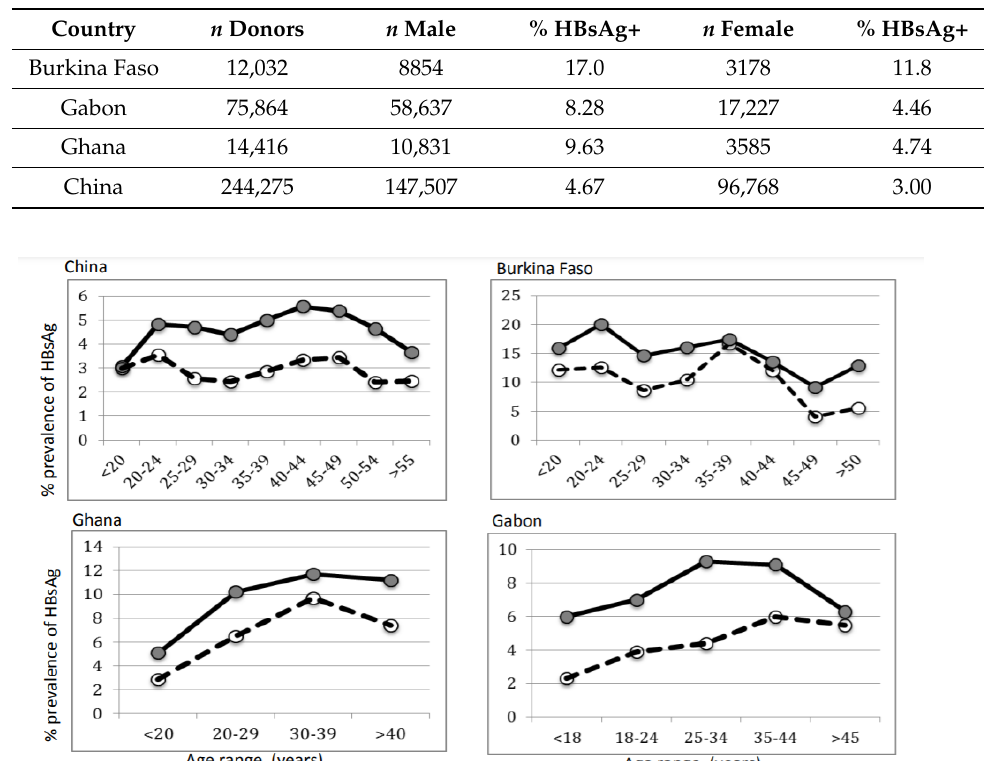
Table 2. Distribution of donors according to sex and type of donors.